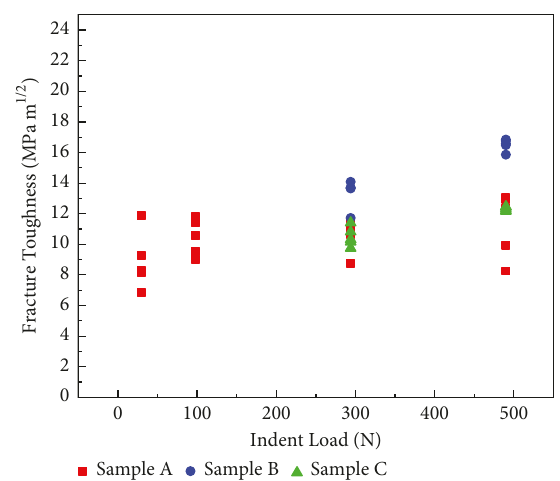
Figure 6: Fracture toughness of the ion-nitrided specimens.